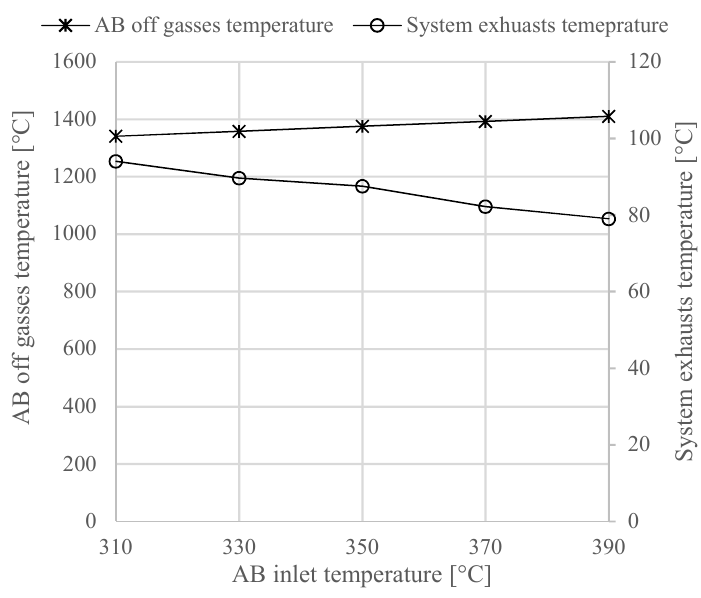
Figure 6. AB off gasses and system exhaust temperatures as function AB inlet temperature.